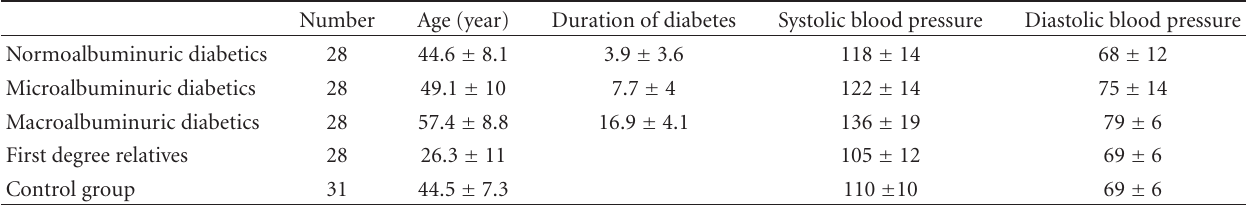
Table 1: Comparisons of age and systolic and diastolic blood pressure in individuals of five groups and duration of diabetes in three groups of diabetic patients.